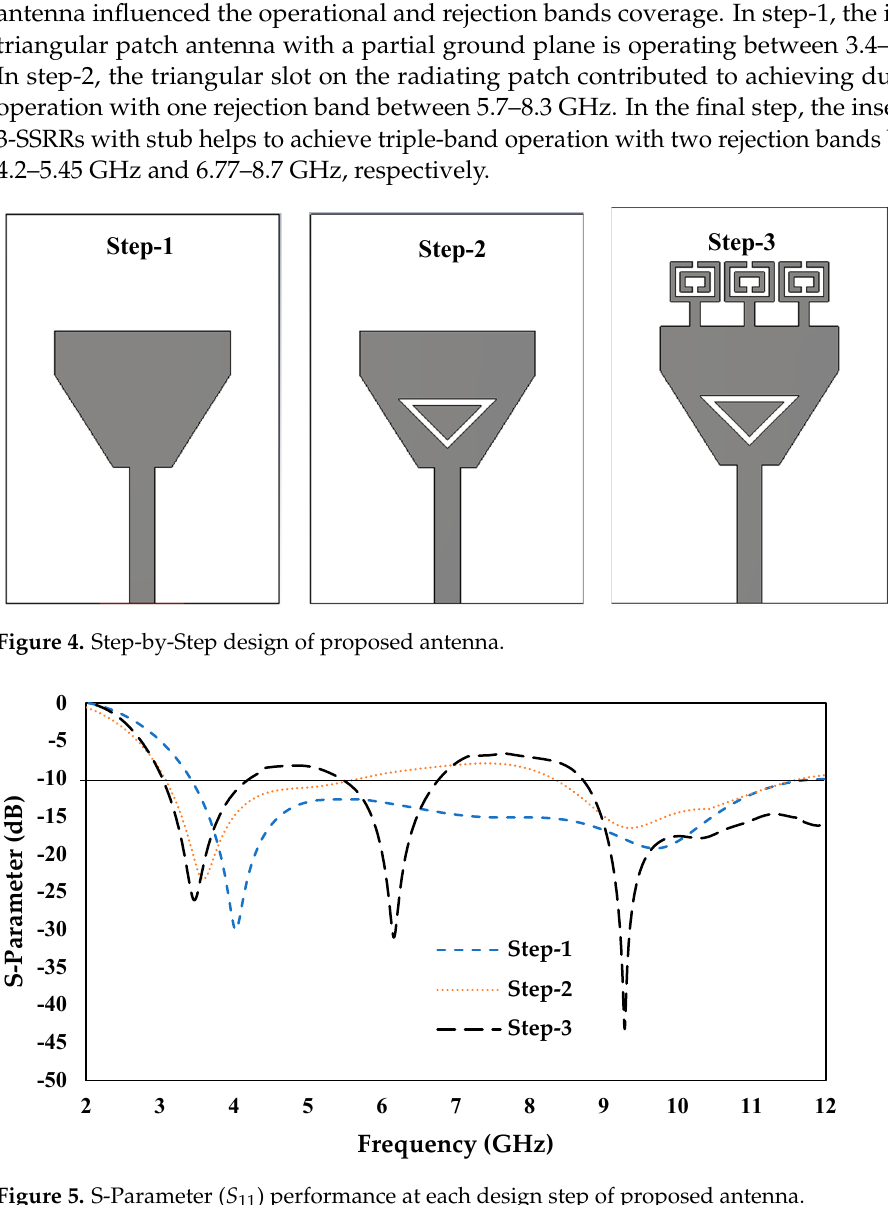
Figure 3. Performance analysis of SSRR unit-cell ( a ) S-parameter response ( b ) Refractive index re- sponse.